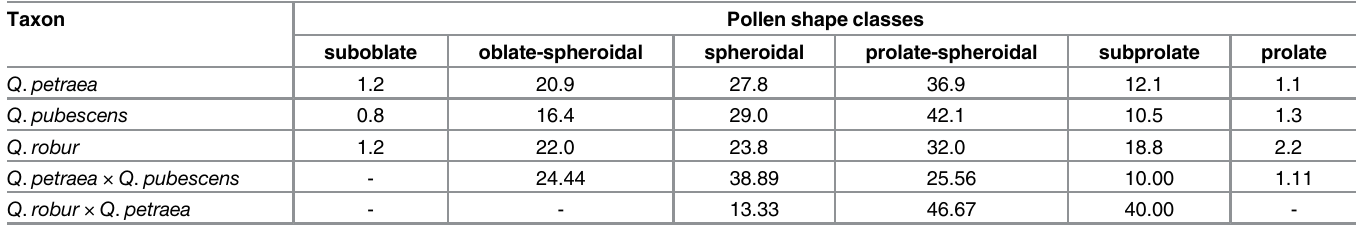
Table 3. The percentage participation of pollen grains in shape classes (P/E ratio) according to Erdtman ’ s (1952) classification.